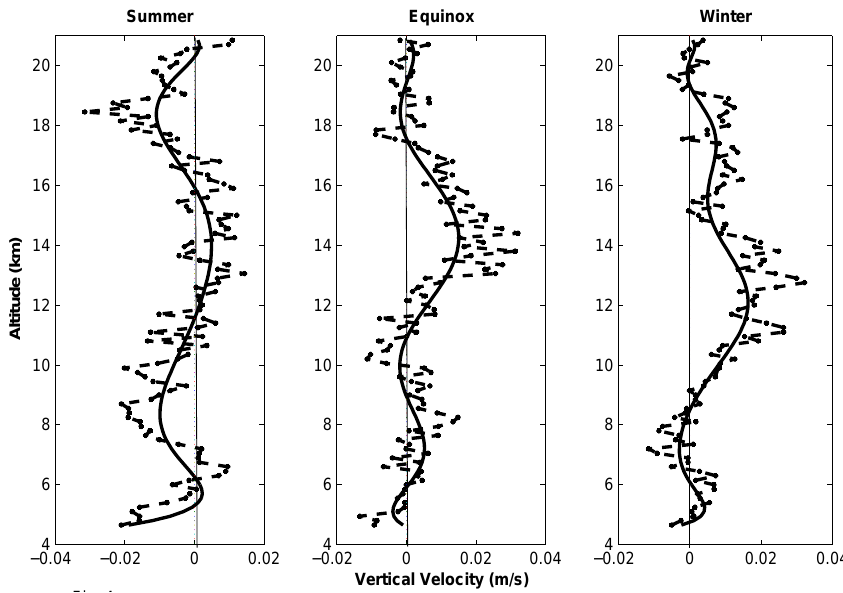
Fig. 4. Seasonal variation of mean vertical velocity (Solid line represents the polynomial fit and dashed line represents the actual profile).